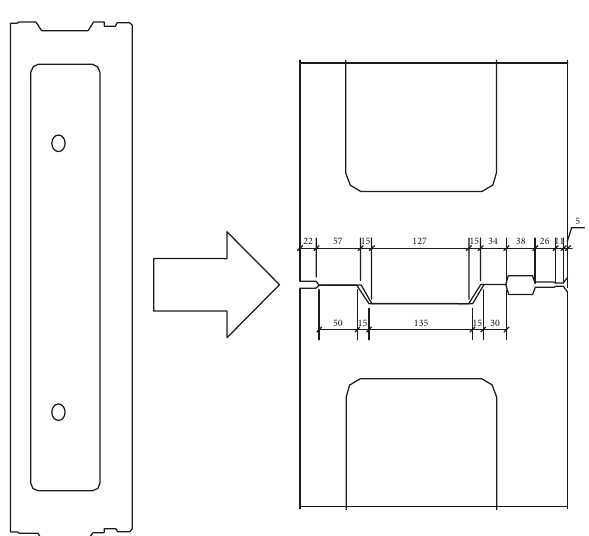
Figure 2: Sketch of tenon between segment rings (unit: